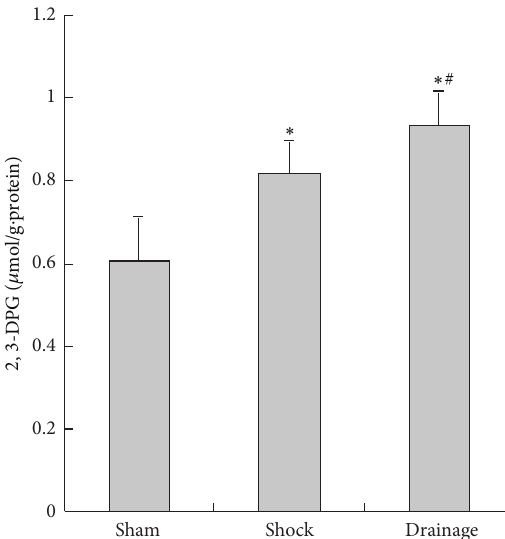
Figure 5: Effects of mesenteric lymph drainage on 2,3-DPG content of renal homogenate in hemorrhagic shock rats without resuscita- tion ( 𝜇 mol/g ⋅ protein, mean ± SD, 𝑛 = 6 ). ∗ 𝑃 < 0.05 versus sham group; # 𝑃 < 0.05 versus shock group.